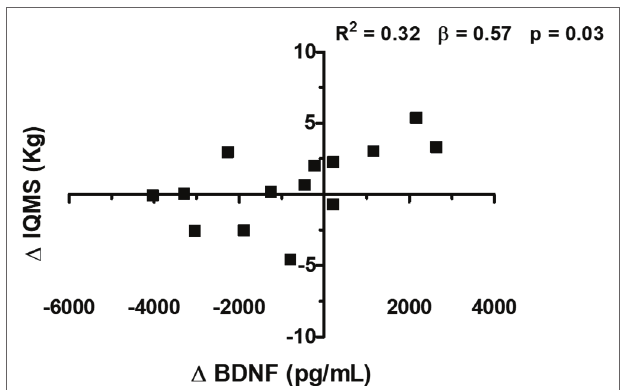
FIGURE 4 | Correlation between the delta (Δ) of the isometric quadriceps muscle strength (IQMS) and plasma concentration of brain-derived neurotrophic factor (BDNF) in older women with osteoarthritis (OA) of the knee. β , standardized regression coefficient; R 2 , R square (Pearson